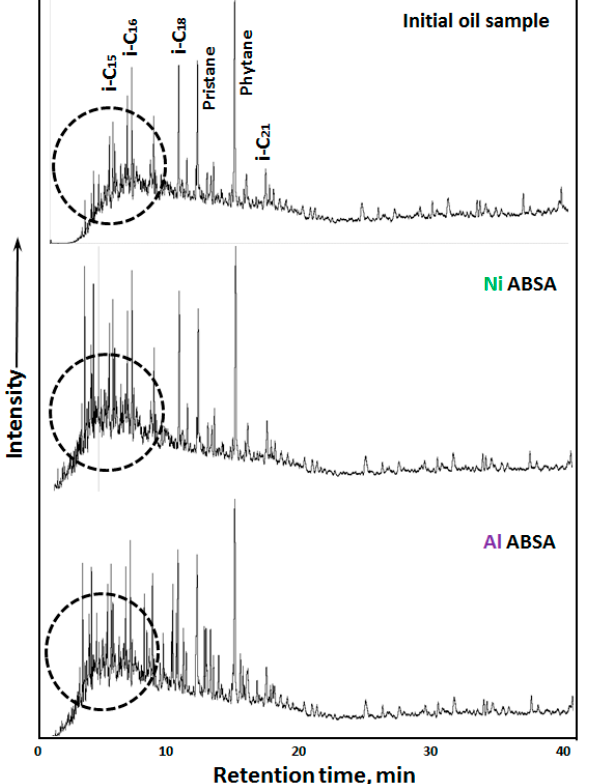
Figure 9. The GC–MS spectra (TIC) of saturates of crude oil samples.